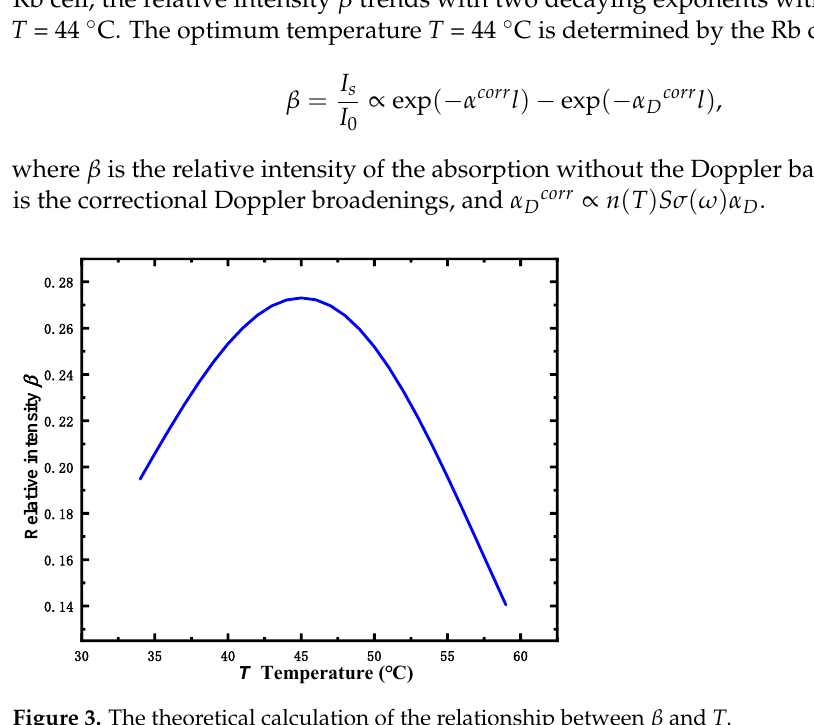
Figure 3. The theoretical calculation of the relationship between β and T .